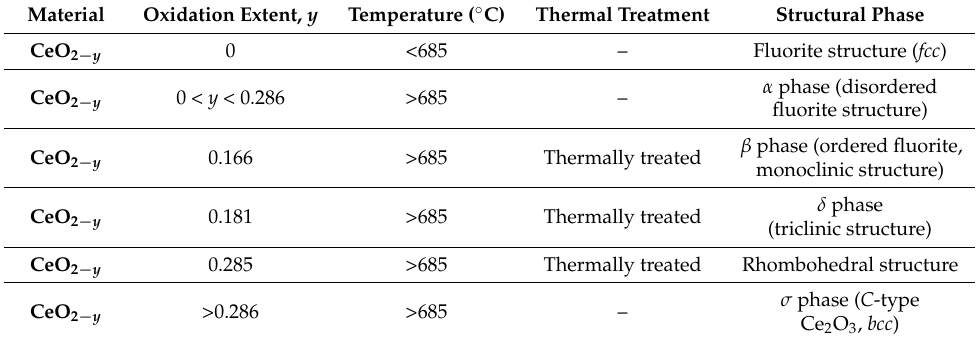
Table 2. Structural changes of stoichiometric and nonstoichiometric CeO 2 with